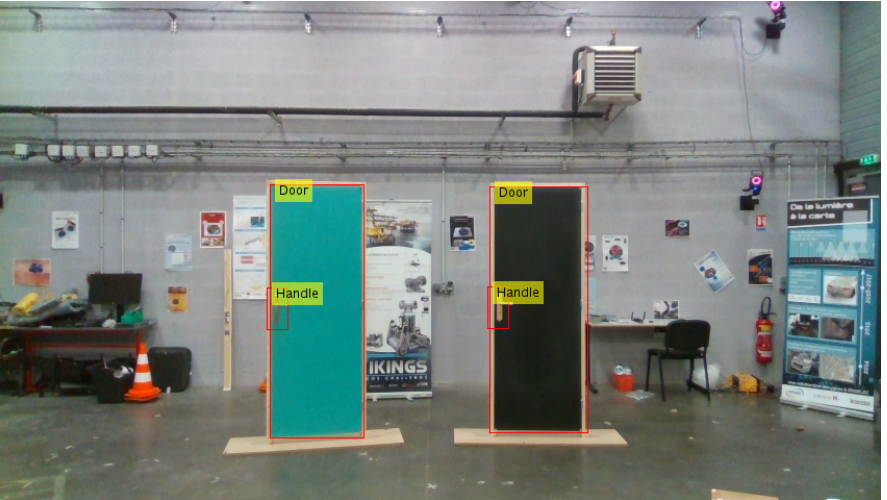
Figure 6. Arrangement of doors in the validation dataset. The ground truth bounding boxes are displayed in red with the associated label overlaid in yellow. In the top-right of figure, we can see a part of the Vicon motion capture system within cameras